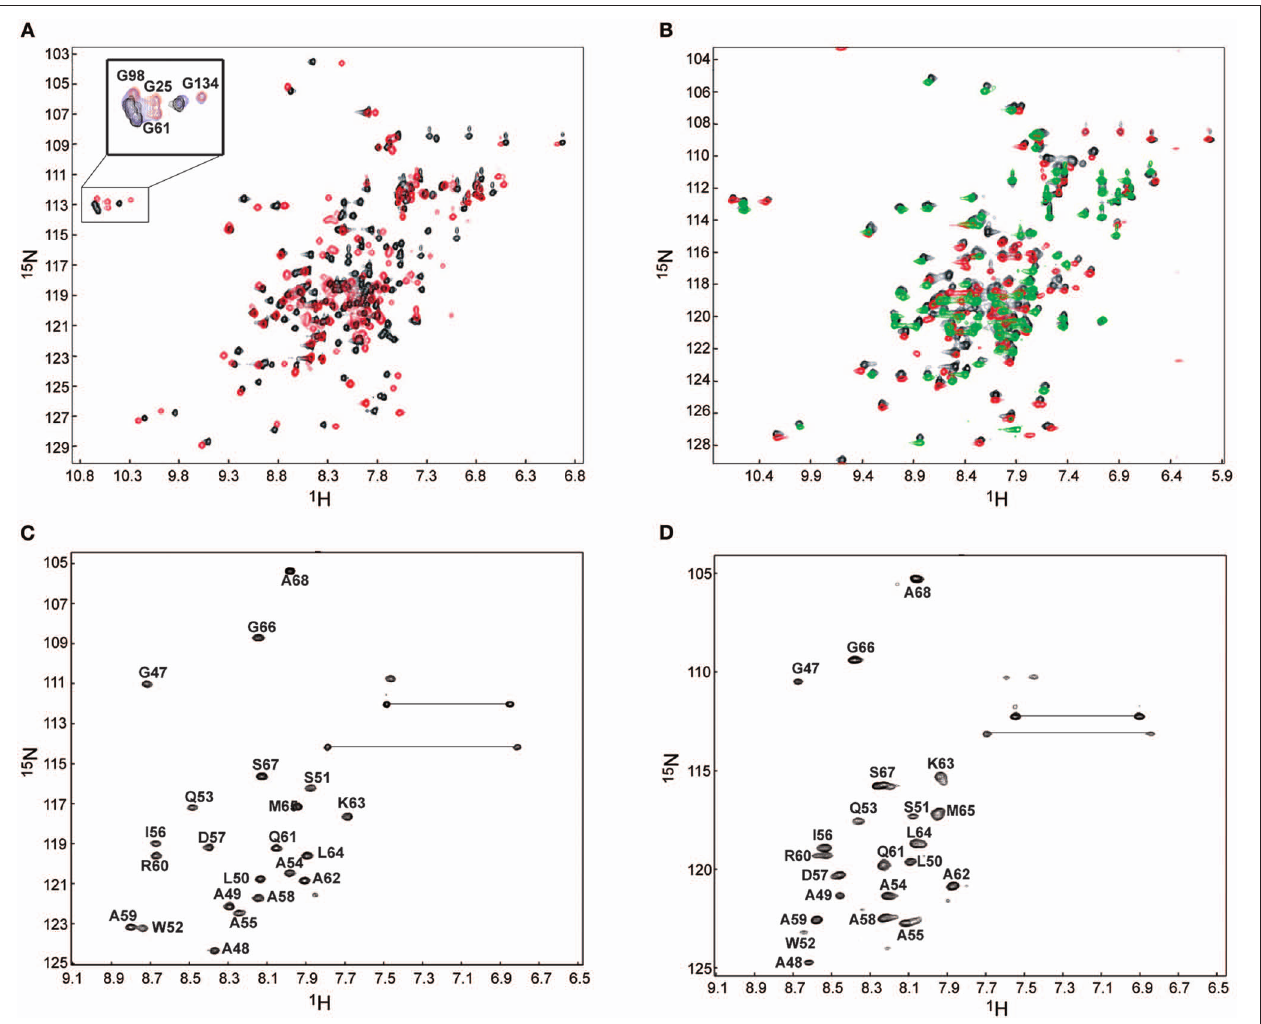
FIGURE 4 | 1 H– 15 N HSQC for the binding of Ca 2 + /CaM to the short NSCaTE peptide. (A) Ca 2 + /CaM is shown in black , and fully peptide saturated Ca 2 + /CaM is red . The conformational change as indicated by the peaks shifts of the four EF-hand Gly residue is highlighted in the top left corner . (B) Superposed HSQC spectra of 13 C/ 15 N-labeled peptides in the complex. Compared with